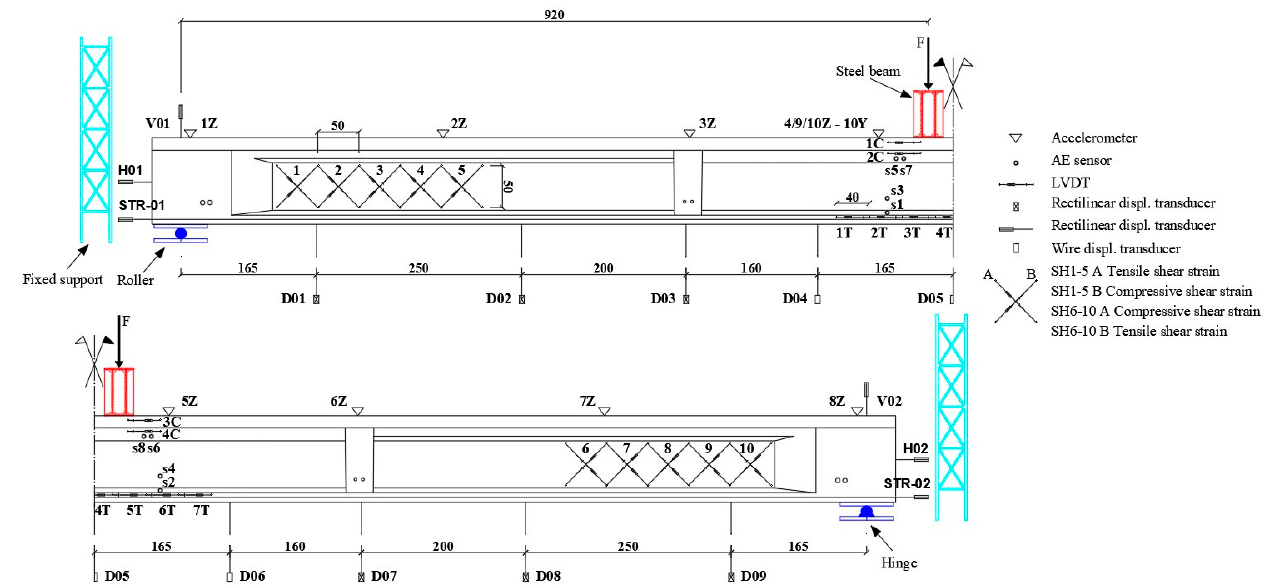
Figure 9. Test setup and layout of the monitoring system installed on the PC girder during the load test (in cm).